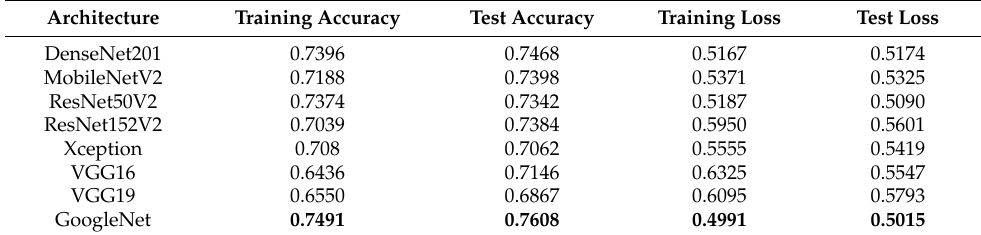
Table 2. Performance comparison between different convolutional neural network models.